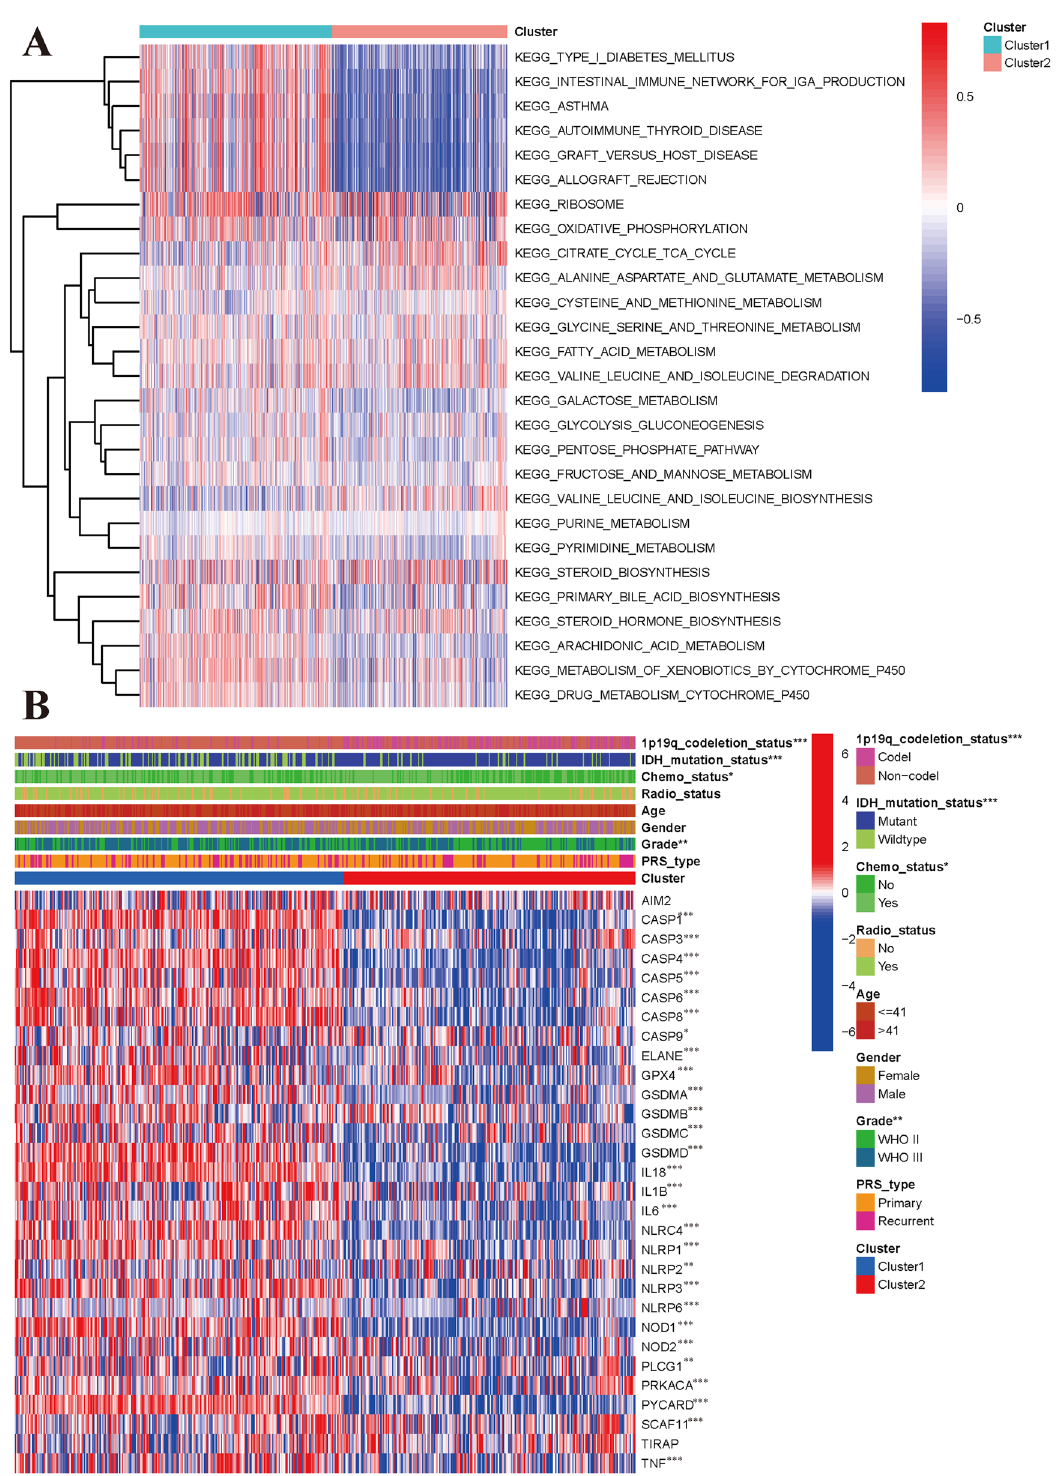
Figure 2. Different pathway enrichment and clinical relevance of two subclasses based on CGGA dataset. ( A ) Gene set variation analysis of two subclasses. ( B ) Expression levels of pyroptosis genes between two subclasses and its correlations with clinical